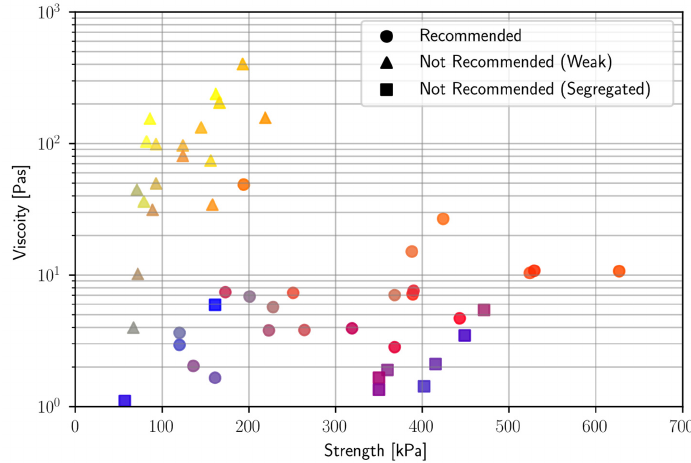
Figure 10. Viscosity vs. strength.